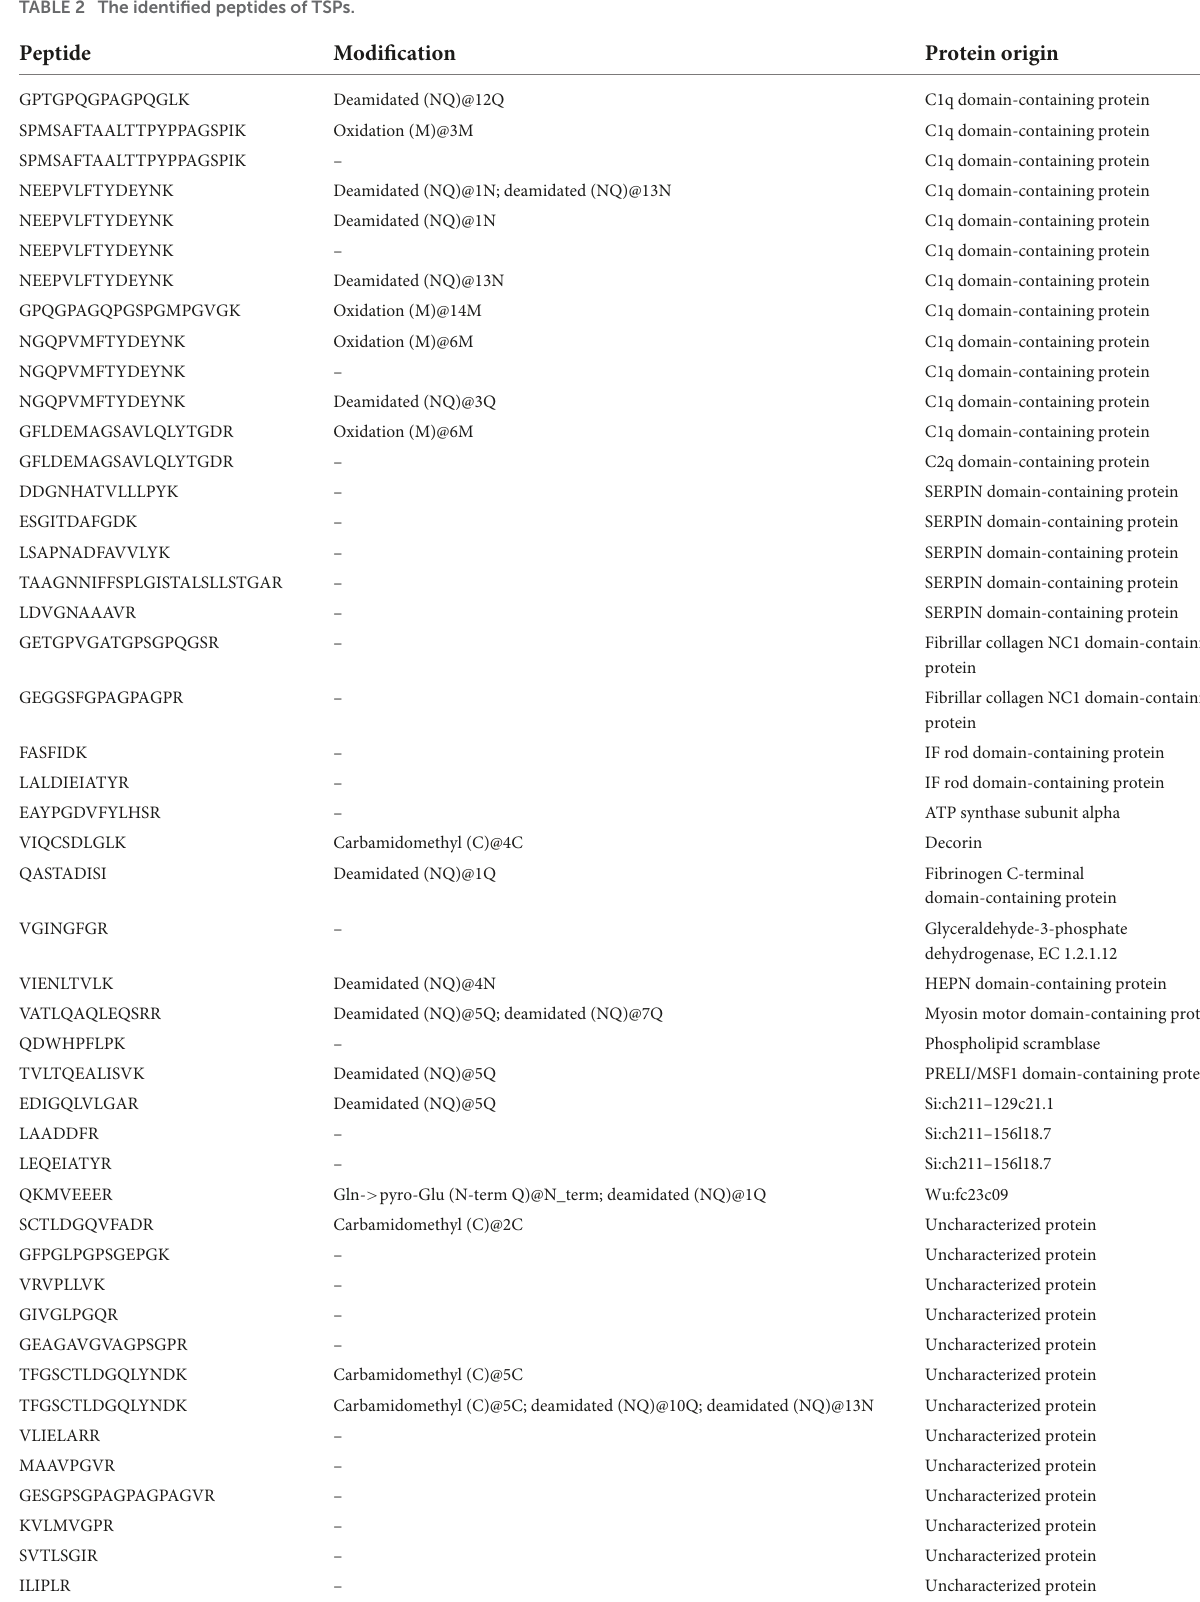
TABLE 2 The identified peptides of